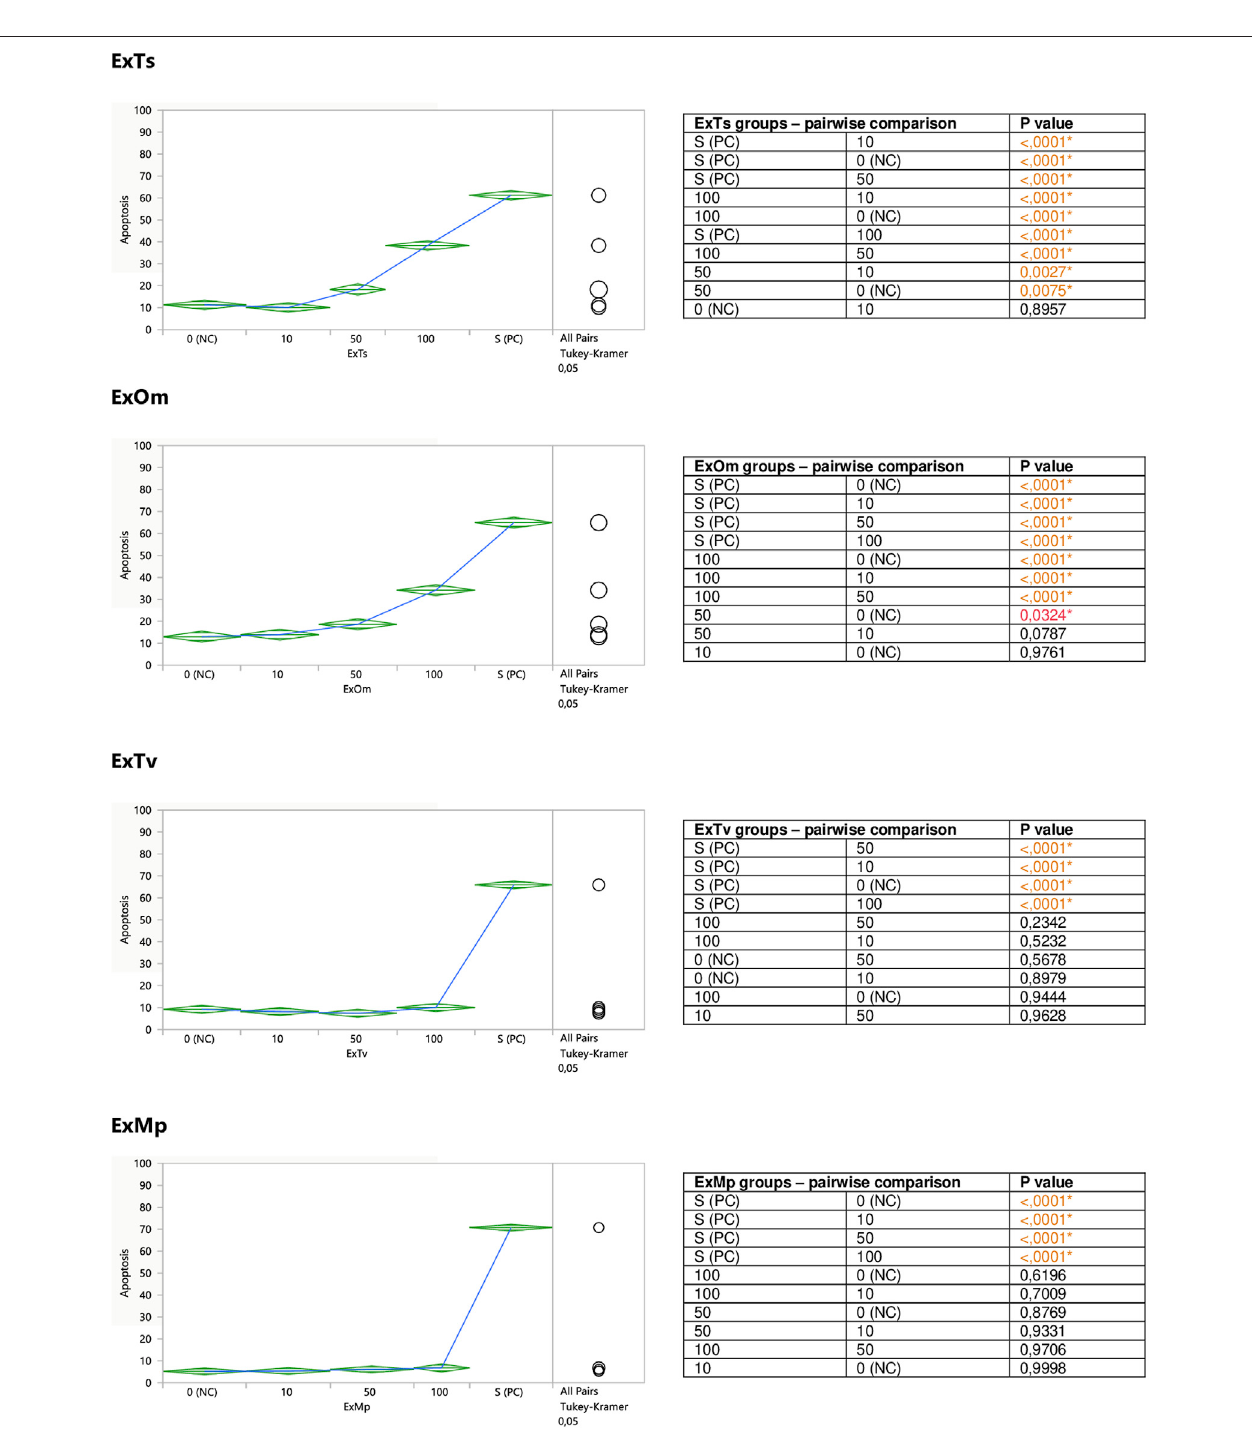
FIGURE 3 | Direct effect of ExTv, ExTs, ExOm, and ExMp on apoptosis of Jurkat cells. 0 (NC) = negative control (untreated Jurkat cells); S (PC) = positive control (Jurkat cells treated with staurosporine); 10, 50, 100 = Jurkat cells incubated with a given extract at the concentration of 10, 50, or 100 μ g/ml. Apoptosis = percent of apoptotic cells. Means diamonds illustrate ANOVA analysis (upper and bottom points are at 95% con fi dence points of each group). The circles on the right express signi fi cant differences between group means (if they do not overlap), or the lack of signi fi cant differences (if they overlap).